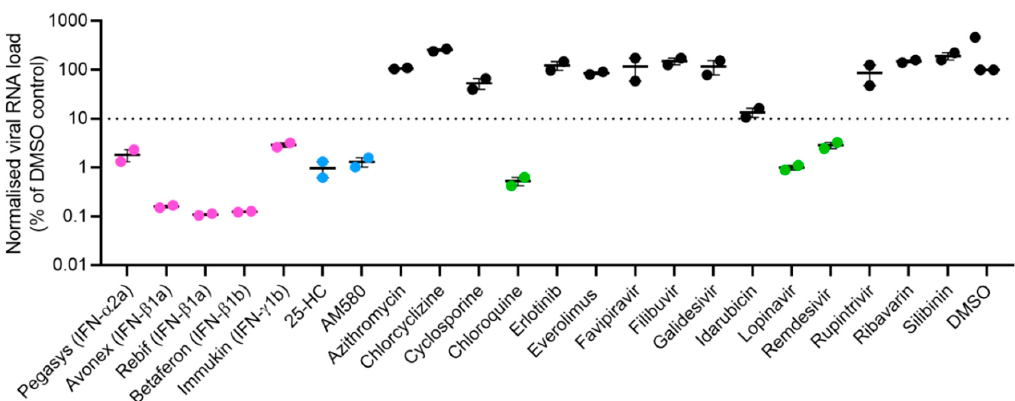
Figure 1. Primary screening of 22 antiviral agents with broad-spectrum antiviral activities against coronaviruses and / or other viruses. VeroE6 cells were infected with SARS-CoV-2 (multiplicity of infection = 0.001) and treated with the fixed concentration of 10,000 IU / mL for each IFN or 20 µ M for each of the other antiviral agents. The cell culture supernatants were collected at 72 h post-inoculation for viral load quantitation by quantitative reverse transcription-polymerase chain reaction. The experiments were performed in triplicate. The cut-off value of ≥ 90% inhibition (i.e., ≥ 1 log10 copies / mL reduction when compared with the DMSO control) was used to select the antiviral agents for further evaluation (magenta dots = recombinant interferons, blue dots = lipogenesis modulators, and green dots = antiviral agents recently reported to be active against SARS-CoV-2). Abbreviation: 25-HC, 25-hydroxycholesterol; DMSO, dimethyl sulfoxide.